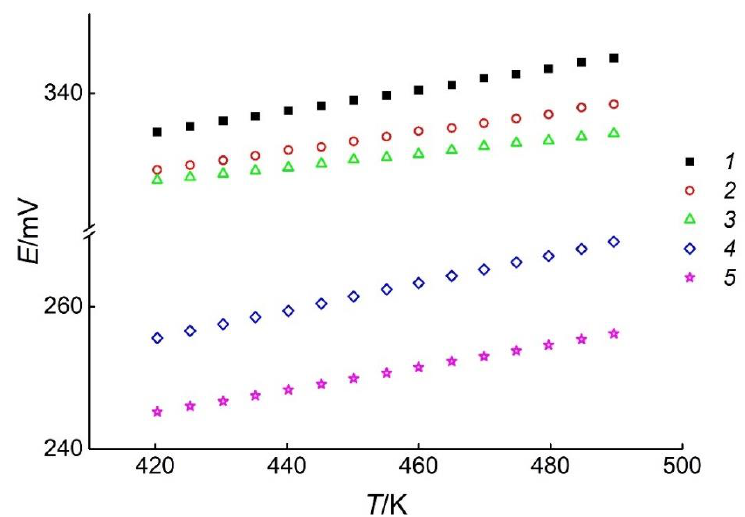
Figure 5. The E vs. T dependences of the GCs with positive electrodes of different phase assemblages. Sets of symbols numbered from 1 to 5 correspond to the phase regions In 2 Te 3 – In 2 Te 5 – Ag 3 In 97 Te 147 (I), In 2 Te 5 – Te – Ag 3 In 97 Te 147 (II), Ag 3 In 97 Te 147 – Te – AgIn 5 Te 8 (III), AgIn 5 Te 8 – Te – AgIn 3 Te 5 (IV), and AgIn 3 Te 5 – Te – AgInTe 2 (V), respectively.